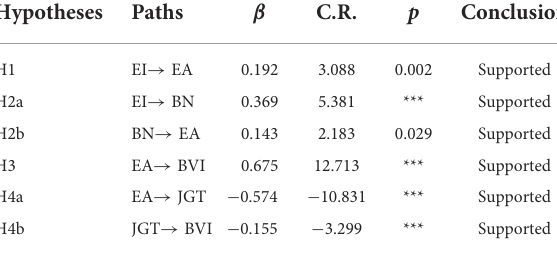
TABLE 8 SEM test